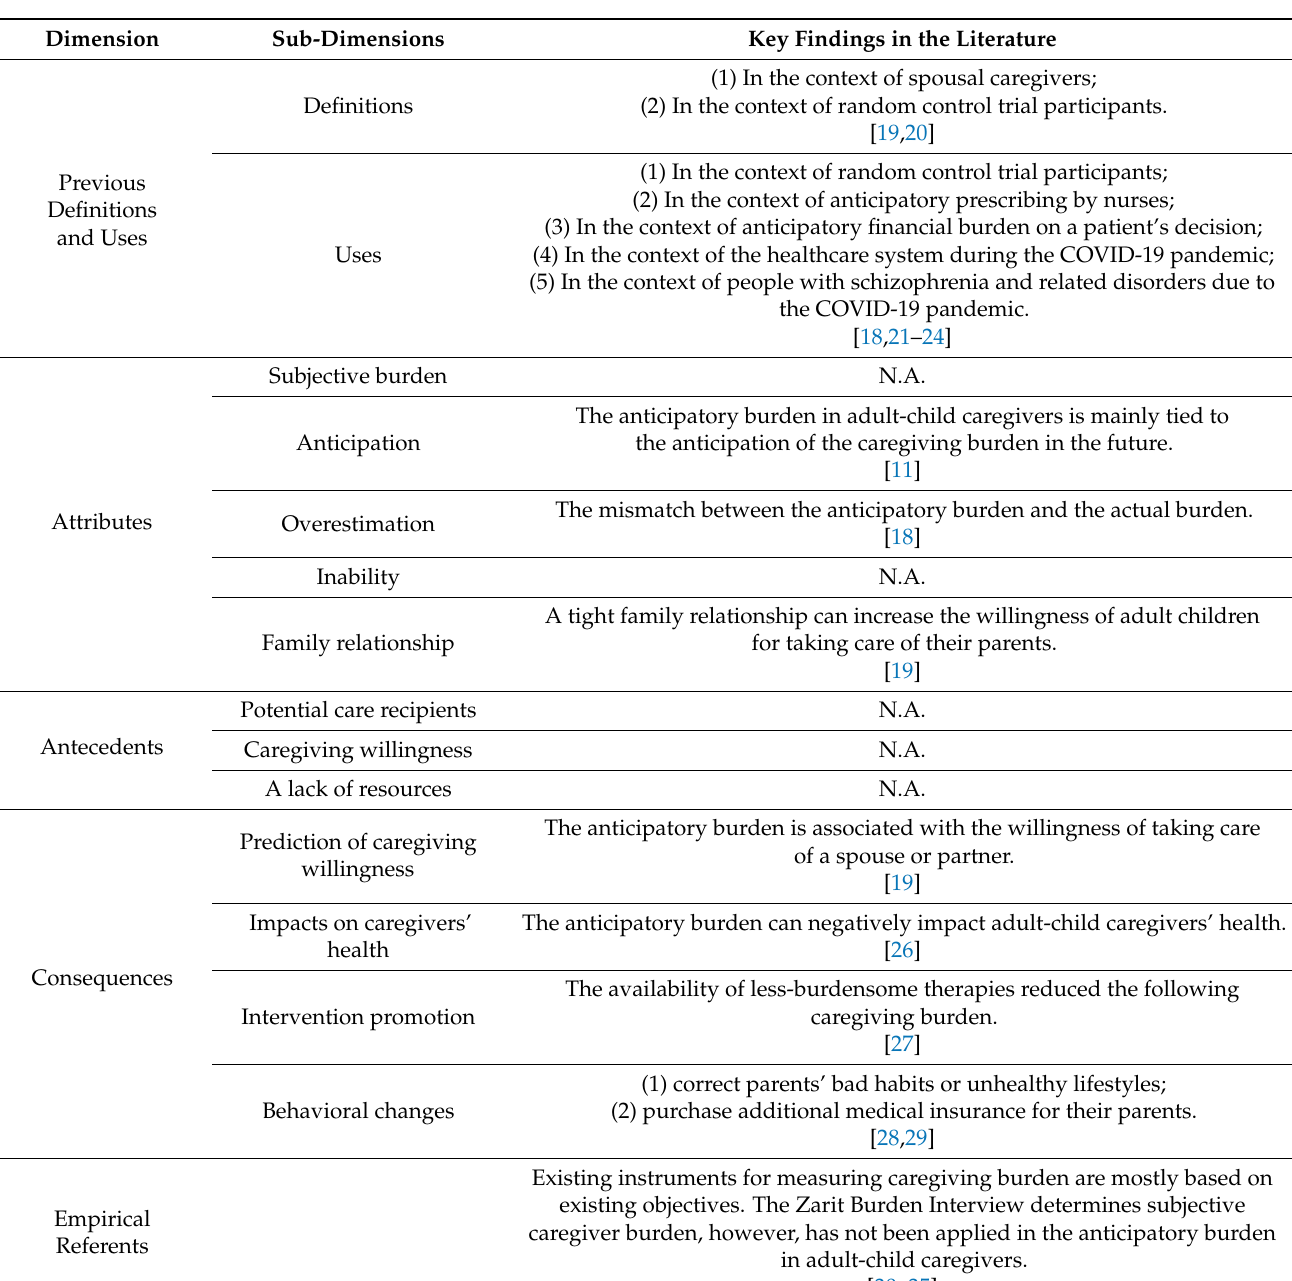
Table 1. Previous definitions and uses, attributes, antecedents, attributes, and consequences of anticipatory burden in adult-child